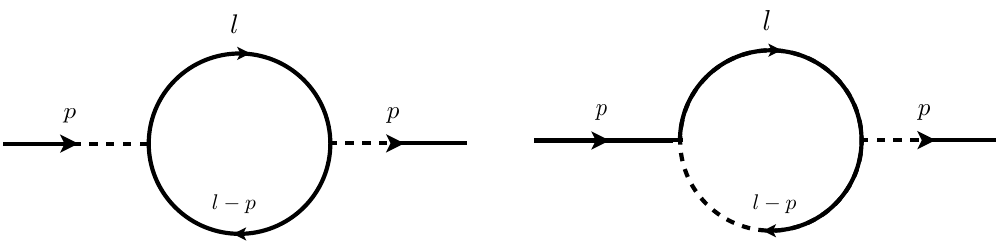
Figure 6 . The Feynman diagrams for the one-loop renormalization of h ϕ ( p ) ϕ ( − p ) i